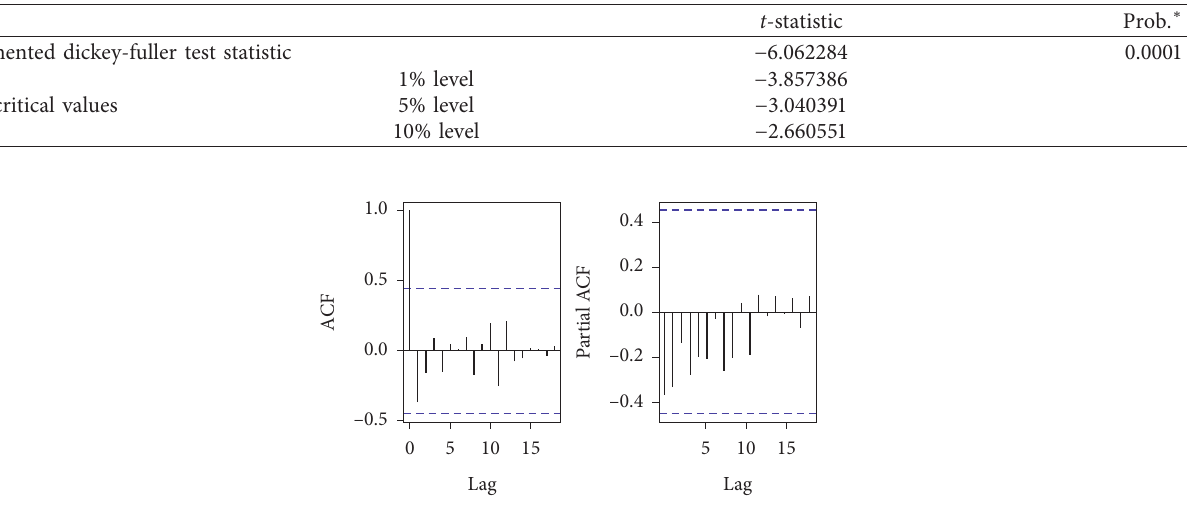
Table 7: ADF inspection of Oman crude oil prices.